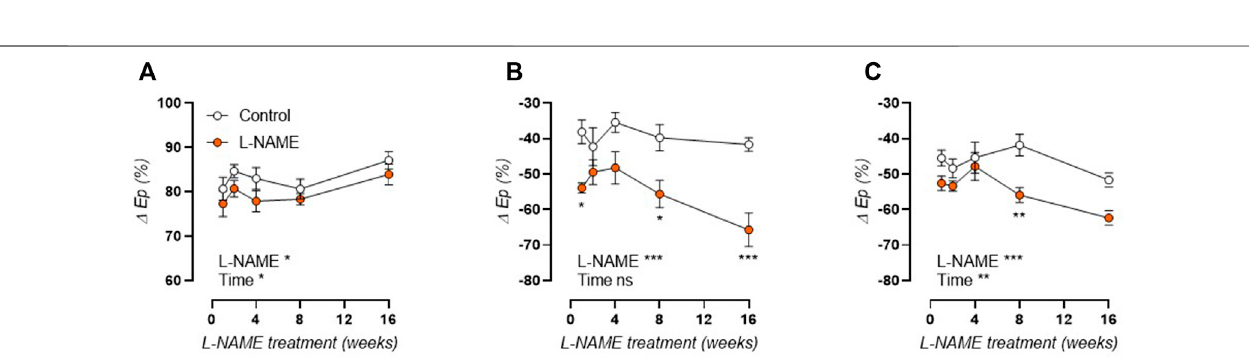
FIGURE 8 | Reduced basal NO levels and increased voltage-gated calcium channel contribution in L-NAME treated mice. Basal NO levels were calculated as the relative difference in E p (80 – 120 mmHg distending pressure) by 2 μ M PE in the absence and presence of NOS blocker L-NAME (300 μ M, (A) ) in L-NAME treated (n ≥ 7) and control (n ≥ 9) mice. The relative effect of 35 µM diltiazem on PE-induced E p increase was used to calculate the contribution of VGCC to contraction-dependent stiffening in the absence (B) and presence (C) of NOS blocker L-NAME (300 µM) in L-NAME treated (n ≥ 7) and control (n ≥ 9) mice. Statistical analysis using two- way ANOVA. Overall signi fi cance (bottom) and post-hoc signi fi cance (in graph) are listed.* p < 0.05, ** p < 0.01, *** p < 0.001.